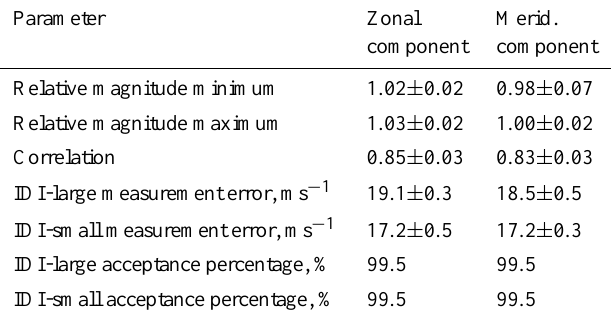
Table 2. Mean and standard deviation of daily relative magnitude minima and maxima, correlation, maximum measurement errors, and acceptance percentages for IDI-large with respect to IDI-small for 19 January 2000 to 3 February 2000.